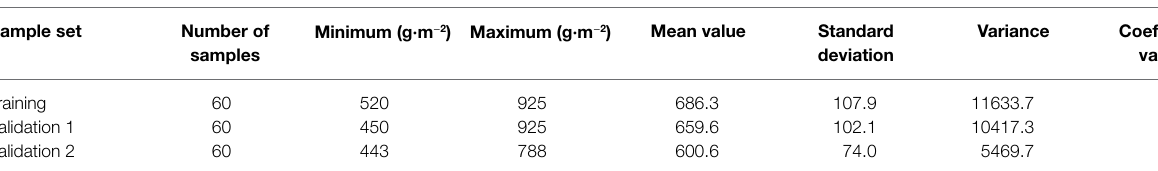
TABLE 2 | Data characteristics.